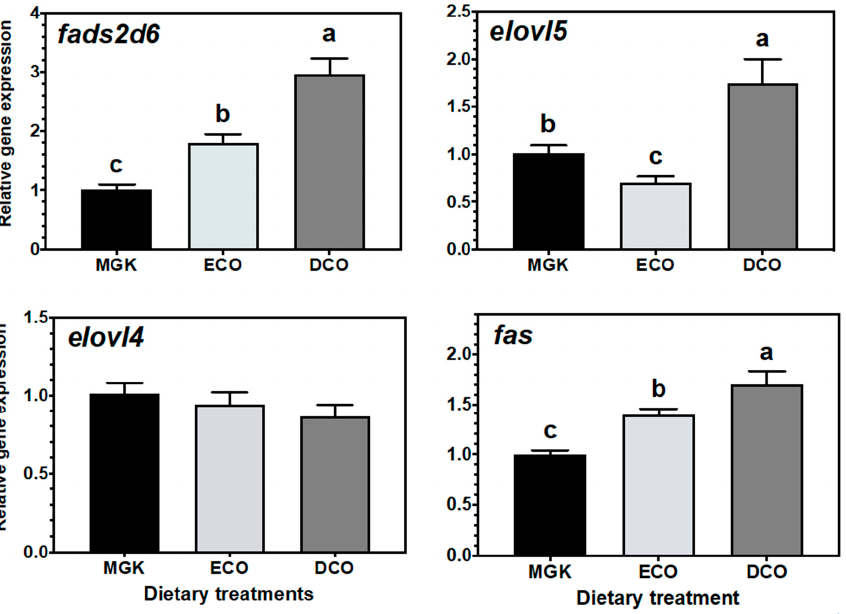
Figure 2. Nutritional regulation of delta-6 fatty acyl desaturase ( fads2d6 ), fatty acyl elongases 4 ( elolv4 ) and 5 ( elovl5 ) and fatty acid synthase ( fas ), gene transcription in intestine of Atlantic bluefin tuna ( Thunnus thynnus L.) juveniles fed a reference diet Magokoro ® (MGK) and two test diets containing either EPA (ECO) or EPA + DHA (DCO) oils from transgenic Camelina sativa seeds. Values are normalised expression ratios to MGK reference diet and are means ± SD ( n = 6). Values with different superscript letters are significantly different (one-way ANOVA and Tukey test; p <